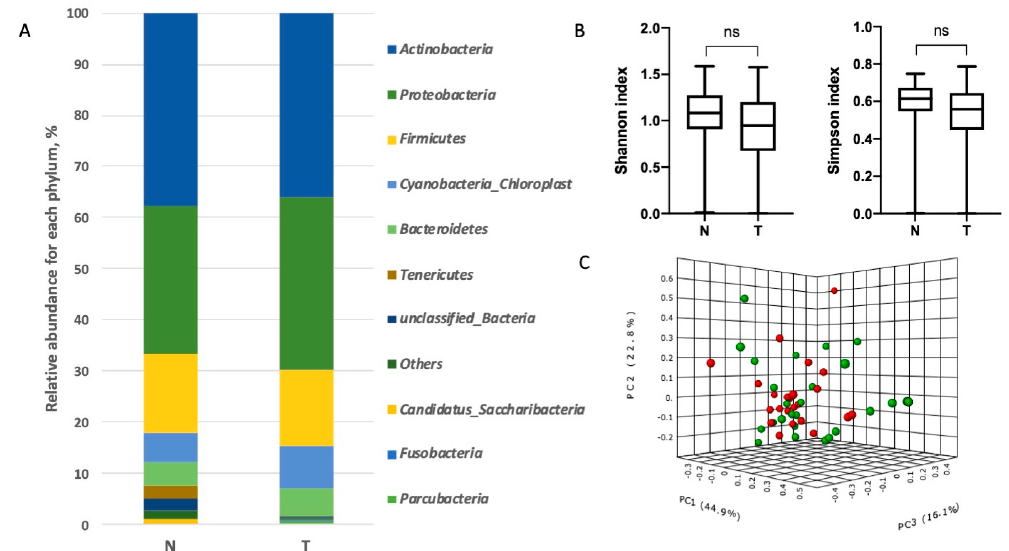
Figure 1. Taxonomic composition of the microbial community of lung tissues on the level of phylum. ( A ). Characterization of non-small cell lung cancer (NSCLC) microbiota. Relative abundance at the phylum level for tumor (T) and normal tissue (N) samples. ( B ). Taxonomic α -diversity calculated with the Shannon and Simpson indices between N and T groups (ns=non significant). ( С ). Principal coordinates analysis (PCoA) plot based on the Bray–Curtis distances of NSCLC microbiomes between tumor and normal tissues (PERMANOVA) F-value: 0.81483; R-squared: 0.016692; p -value < 0.507 (green ball – tumor, red ball – normal tissue).